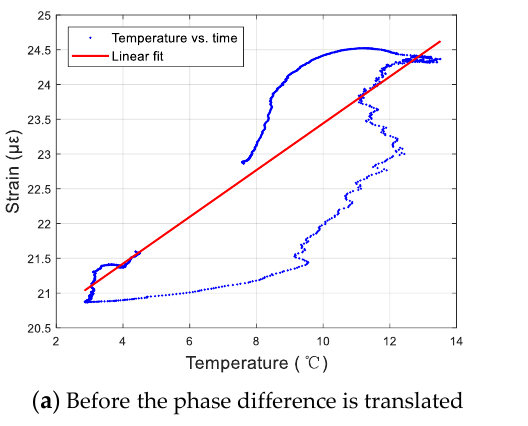
Figure 9. Temperature vs. strain plots in winter (27 November 2017).